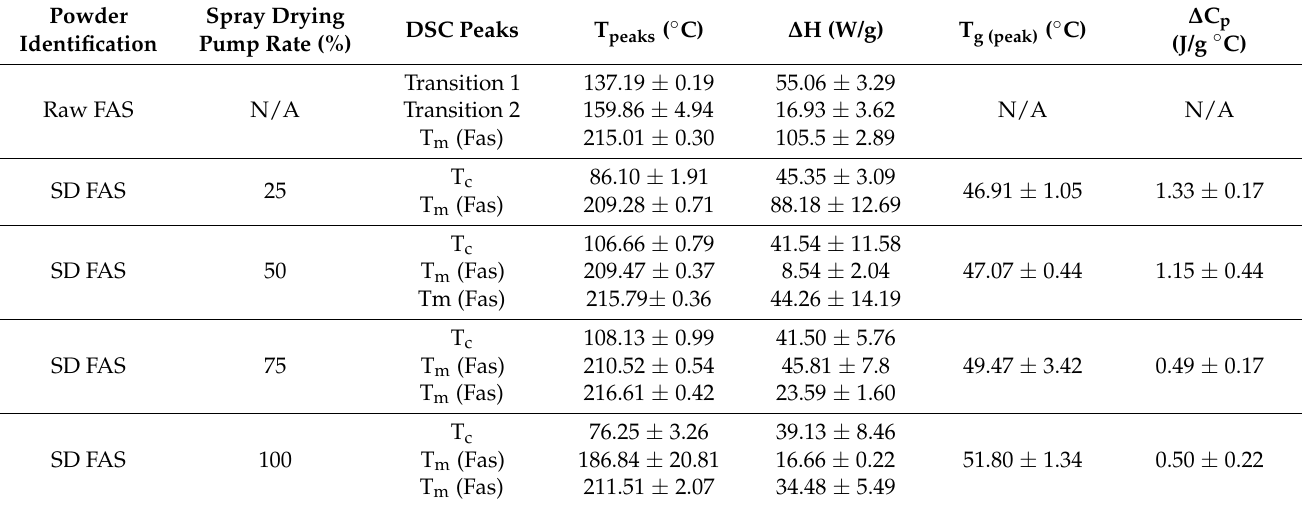
Table 3. DSC thermal analysis. ( n = 3, mean ± standard